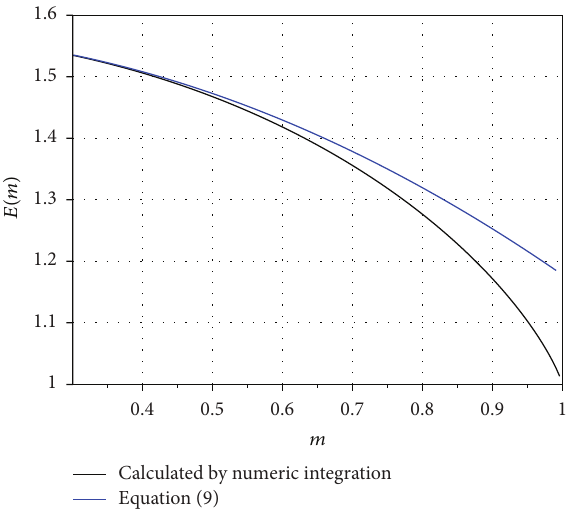
Figure 3: Comparison between numerical integration and power series approximation for elliptic integral of the first kind. Figure 4: Comparison between numerical integration and power series approximation for elliptic integral of the second kind.